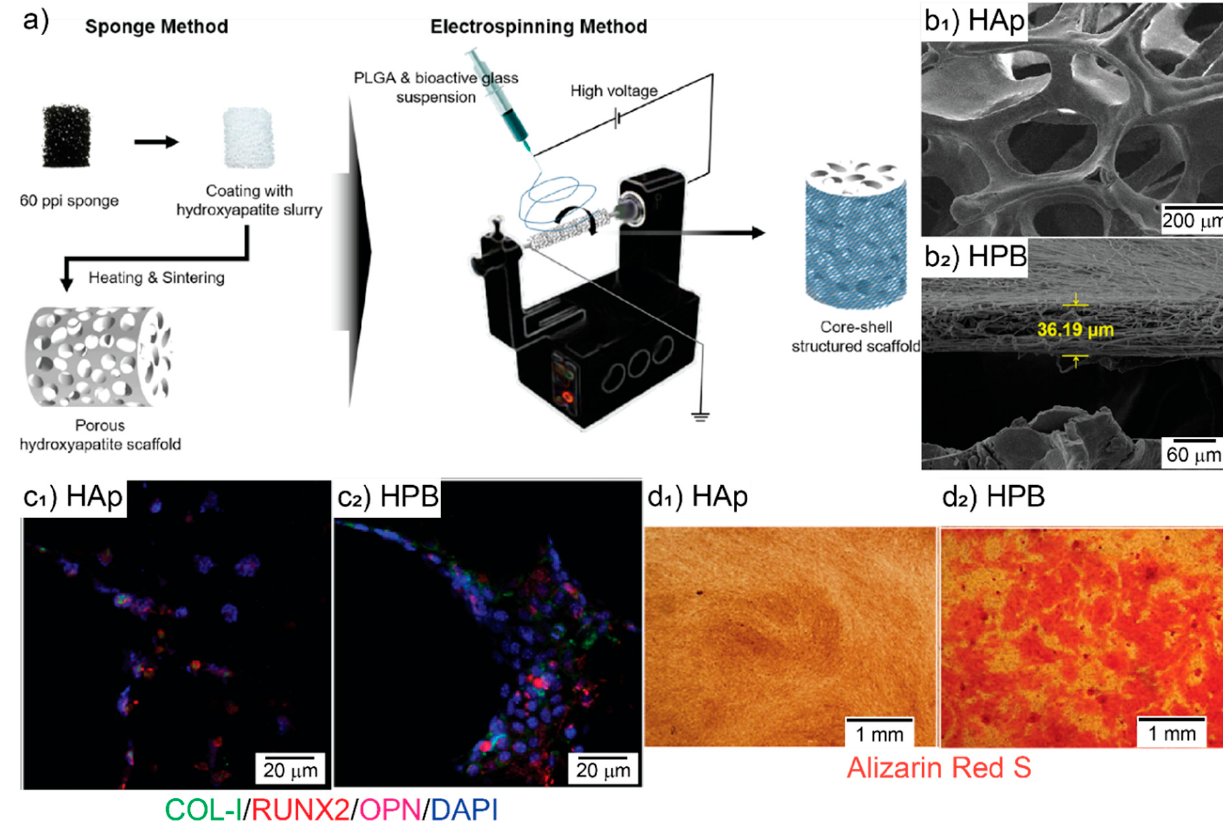
Figure 3. Scaffold combining synergistic physicochemical and biochemical cues for TERM. ( a ) Schematic representation of the fabrication of porous HA scaffolds covered with a BG-containing PLGA fiber layer (HPB). ( b 1 , b 2 ) Representative SEM images of porous HA and HPB scaffolds, respectively. The thickness of BG-containing PLGA microfibers is shown. ( c 1 , c 2 ) Osteogenic activity of MC3T3-E1 cells cultured on HA and HPB scaffolds, respectively. Immunocytochemical analyses of the osteogenic protein expression level of Col I (COL-I, green), runt-related transcription factor 2 (RUNX2, red) and osteopontin (OPN, magenta) following culture for 14 days. ( d 1 , d 2 ) Alizarin red staining performed to observe mineralization of MC3T3-E1 cells by ions released around HA and HPB scaffolds, respectively, on day 21. ( a – d 2 ) adapted with permission from [154], American Chemical Society, 2019. Further permissions to the related material should be directed to the ACS.